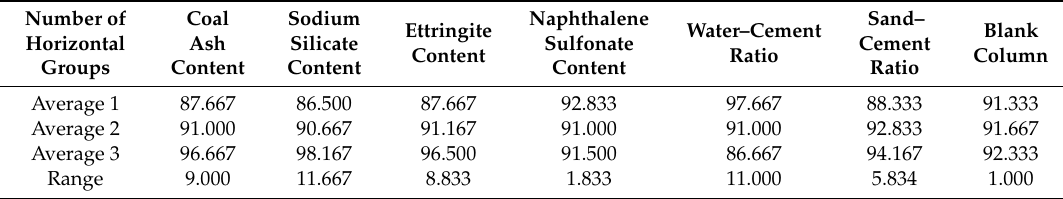
Table 8. Range analysis of adhesion